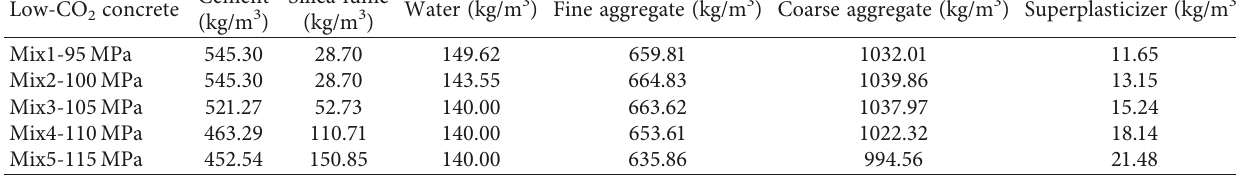
Table 4: Mixtures of low-CO